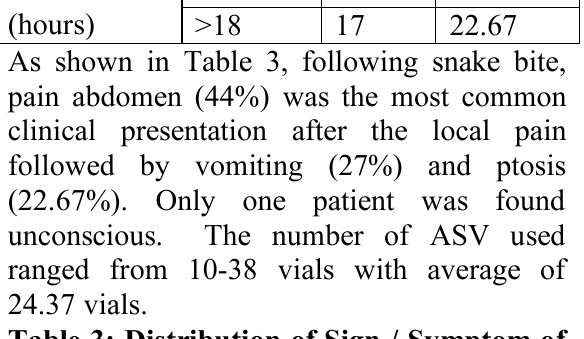
Table 3: Distribution of Sign / Symptom